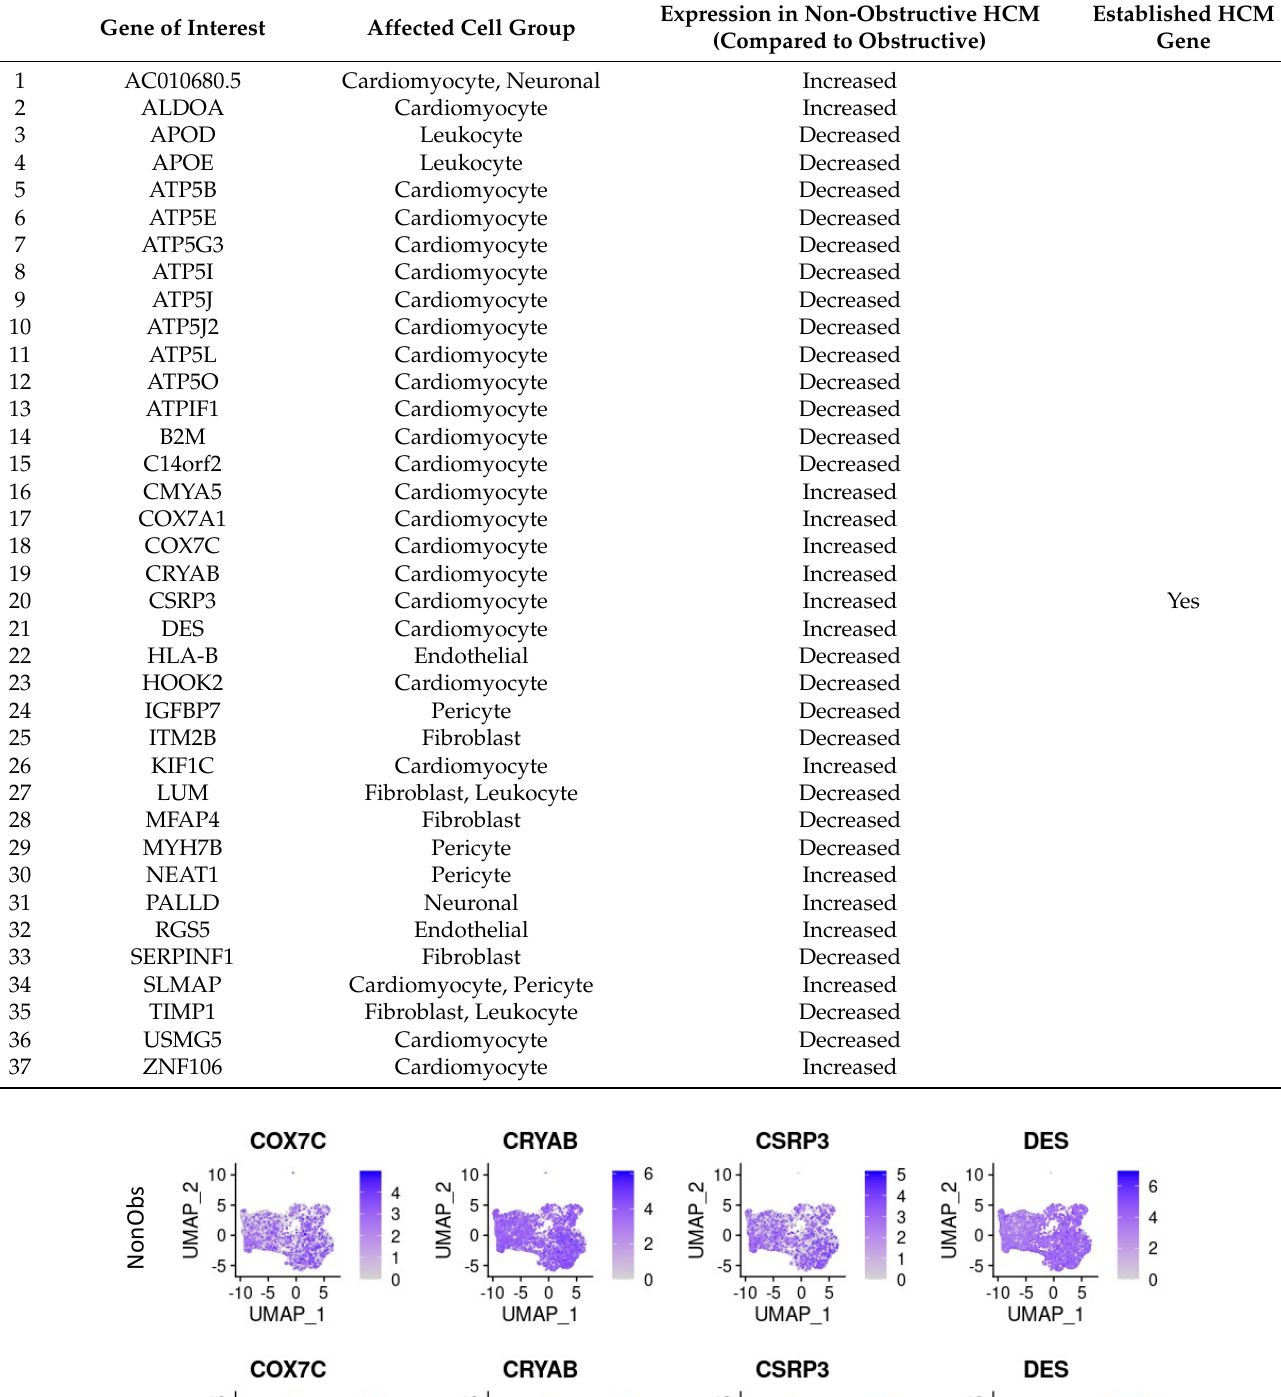
Table 1. Differentially expressed genes of visual interest in nonobstructive and obstructive HCM.